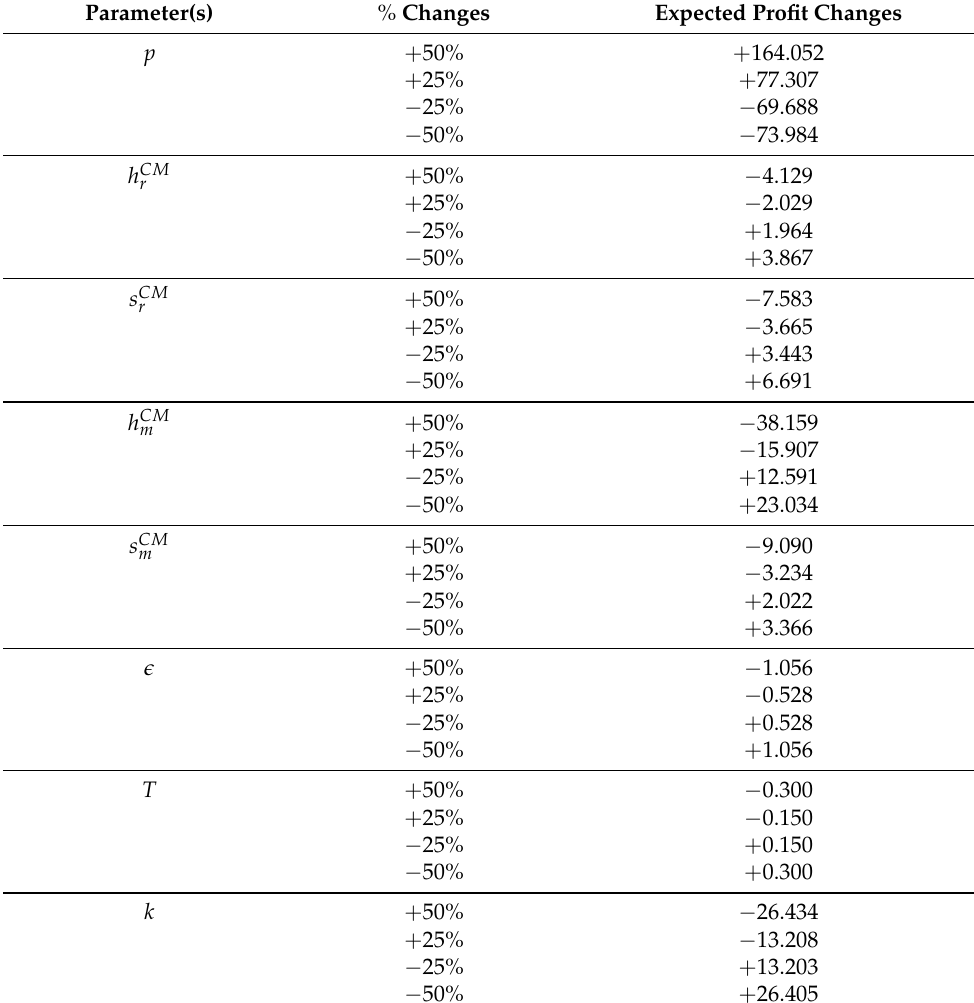
Table 4. Sensitivity analysis of changing